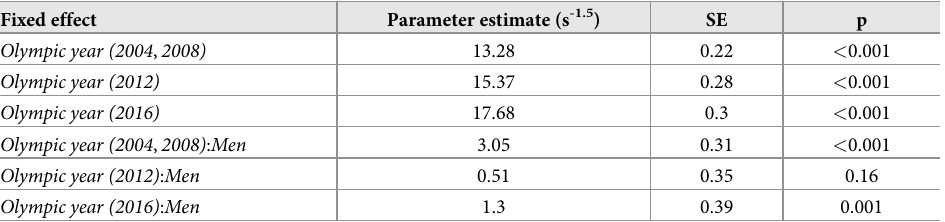
Table 1. Linear mixed-effect model for transformed minimum reaction times (s -1.5